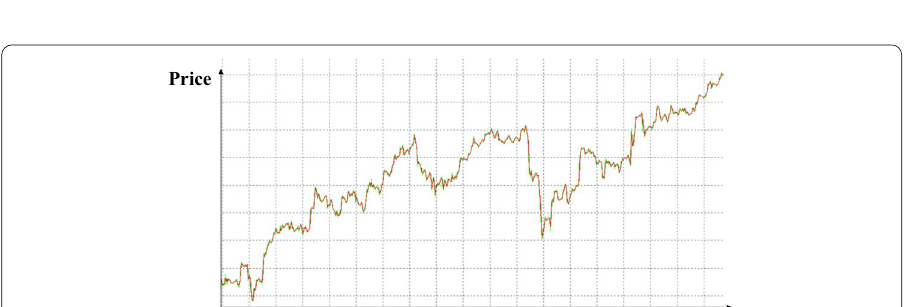
Fig. 2 Test chart of BP network model